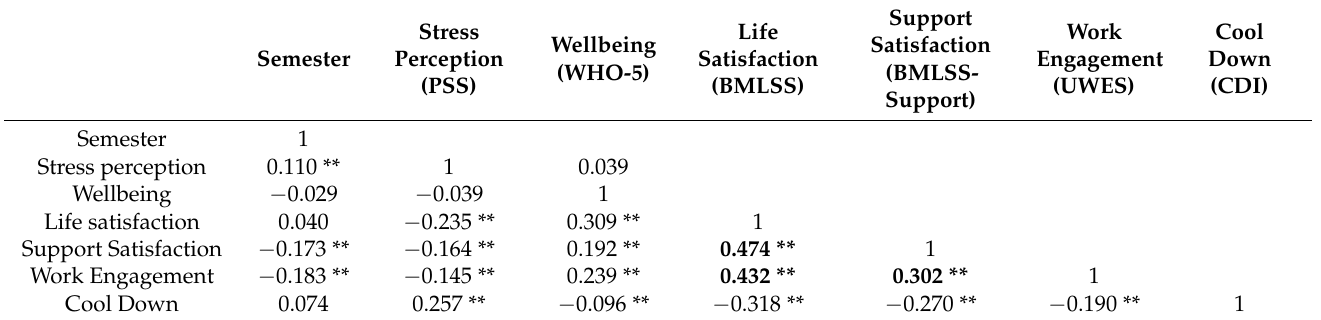
Table 4. Correlations between indicators of stress and wellbeing within the whole sample of students.